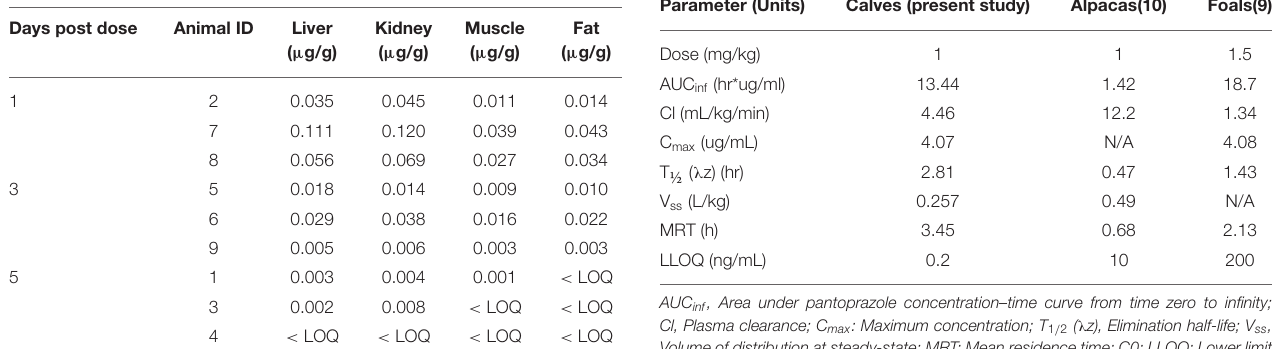
TABLE 2 | Tissue concentrations of pantoprazole sulfone ( µ g/g) in collected tissues 1, 3, and 5 days after intravenous administration of pantoprazole (1 mg/kg) from study calves.